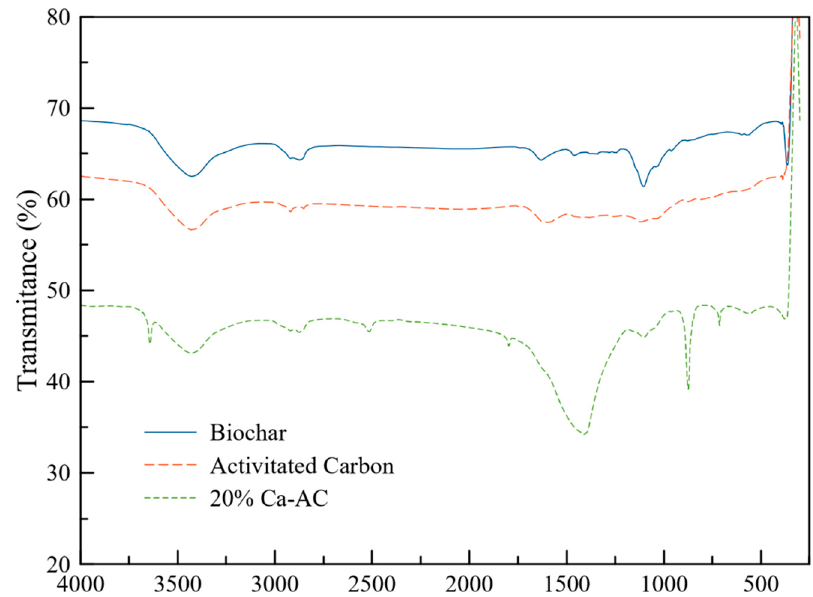
Figure 3. FTIR of Biochar, Activated carbon and 20Ca/AC-650 catalyst.